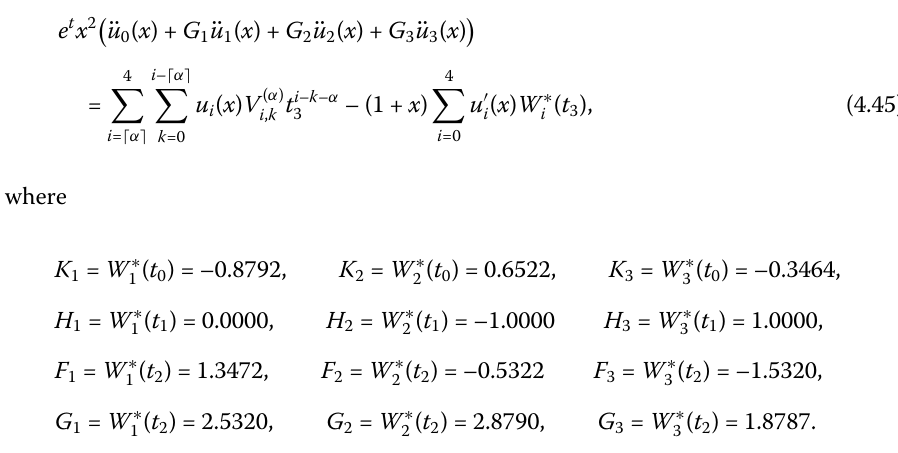
Graphs and Table : The graphical depictions in Fig. 2 show the exact solution and an approximate solution obtained through the shifted Chebyshev spectral method of FFPE on Example 4.2. Also, the absolute error of the present method for m = 3,4, and 5 is displayed in Table 2. As it is expected, accuracy of the method increases, i.e., the absolute error gets very small upon increasing the value of m , since the proposed method is based on the idea of infinite series.